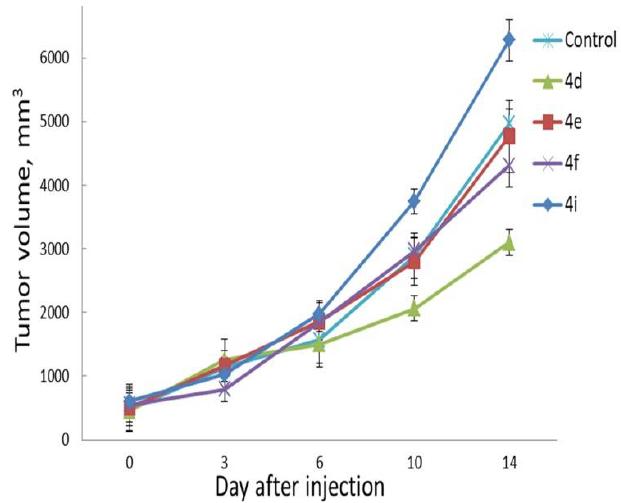
Figure 17. Dynamics of tumor growth with a single intraperitoneal administration of drugs based on 3-azaspiro[bicyclo[3.1.0]hexane-2,5′-pyrimidines] 4d , 4e , 4f , and 4i . Bars indicate  SD. 3-azaspiro[bicyclo[3.1.0]hexane-2,5 (cid:48) -pyrimidines] 4d , 4e , 4f , and 4i . Bars indicate ±